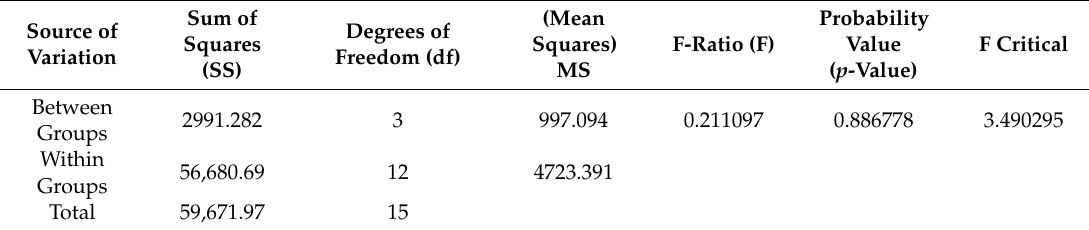
Table A7. ANOVA: Single Factor (Kt).